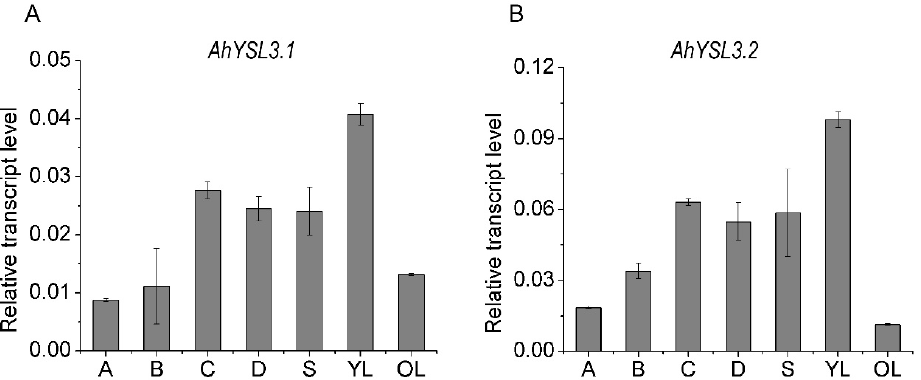
Figure 2. AhYSL3 . 1 ( A ) and AhYSL3 . 2 ( B ) transcript levels in the indicated parts of peanut plants. The following parts of peanut plants grown under normal conditions for 7 days were harvested: 0–2 cm root tips (A from horizontal abscissa), 2–4 cm root tips (B from horizontal abscissa), lateral roots except the above root tips (C), the main roots (D), stems (S), young leaves (YL), and old leaves (OL). Vertical bars indicate relative expression levels relative to the control, ubiquitin . Three biological replicates were performed. Error bars represent standard deviation.